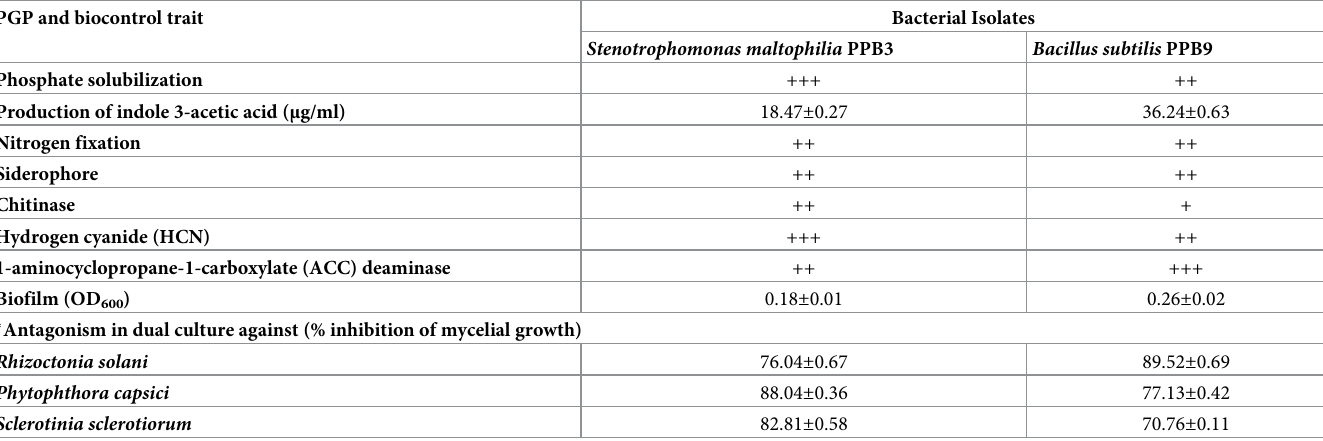
Table 2. Plant growth-promoting (PGP) and biocontrol traits of elite bacterial isolates.